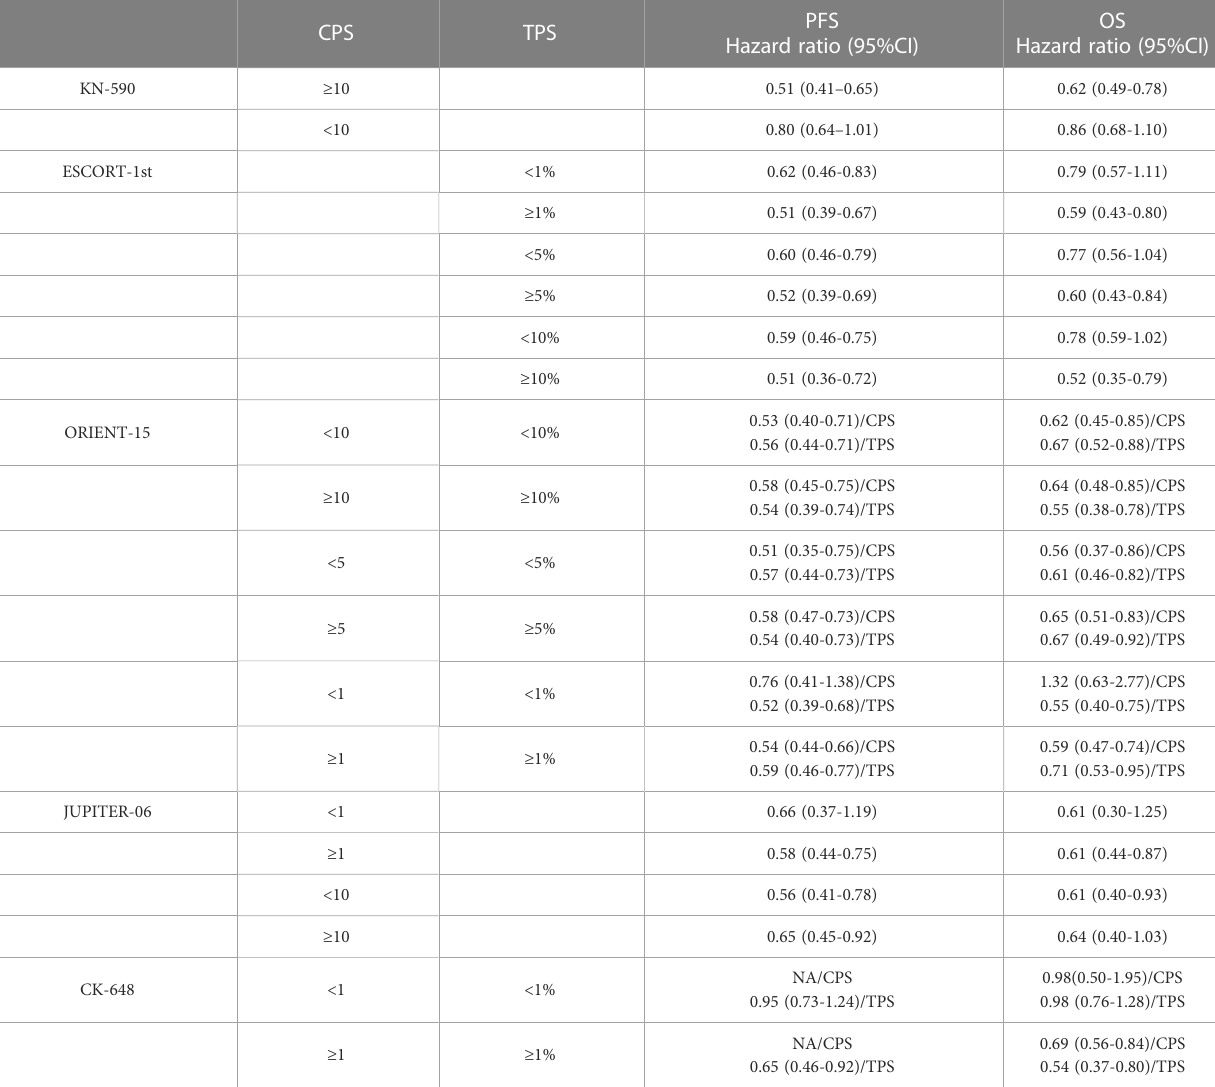
TABLE 1 PD-L1 status and immunotherapy ef fi cacy in phase III clinical trials of esophageal